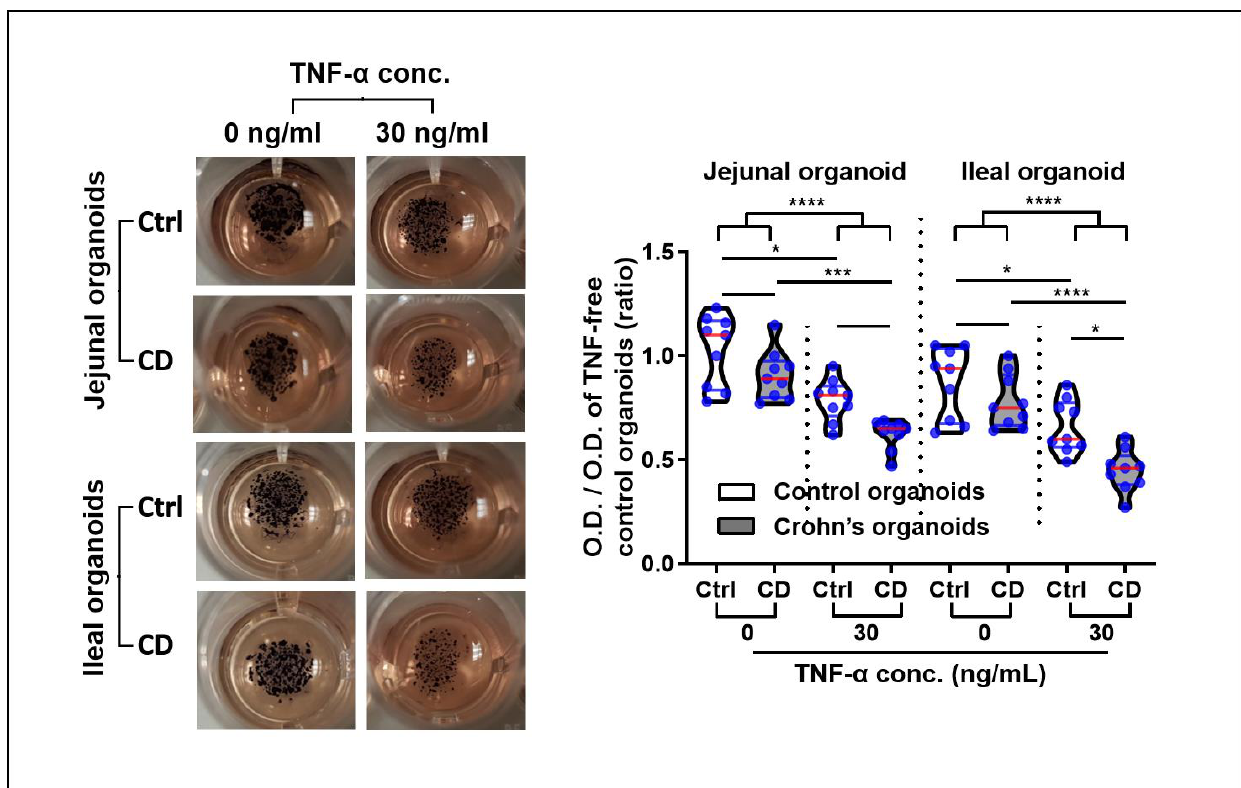
Figure 6. MTT assay for organoid viability in a TNFα-enriched condition. MTT assays were performed in triplicate using jejunal and ileal organoids derived from controls and CD patients (n = 3 each). The optical density (OD) of organoid- containing wells is expressed in a ratio based on the values of the TNFα-free control organoid-containing wells. Differences were evaluated using ANOVA with Bonferroni’s multiple comparison test; * p < 0.05, *** p < 0.001 and **** p < 0.0001.